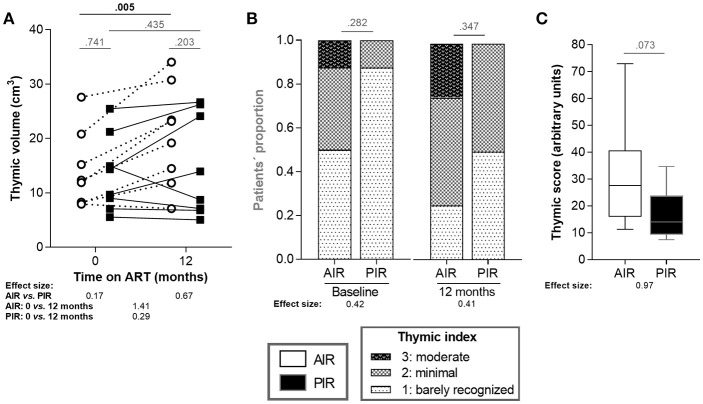
AIR presented thymic volume increase during the first 12 months of ART. (A) Thymic volumes and (B) thymic indices were compared between AIR and PIR at baseline and at 12 months of ART. Thymic indices ranged from 1 to 3. (C) Thymic scores were calculated as the product of thymic volume and index means, over the first year of ART. Thymic volumes and scores (A,C) were compared using independent t-tests and the correspondent effect size estimates were calculated using for Cohen's d. Thymic indices (B) were compared using Fisher's exact test and effect size estimates were calculated using Cramér's V.